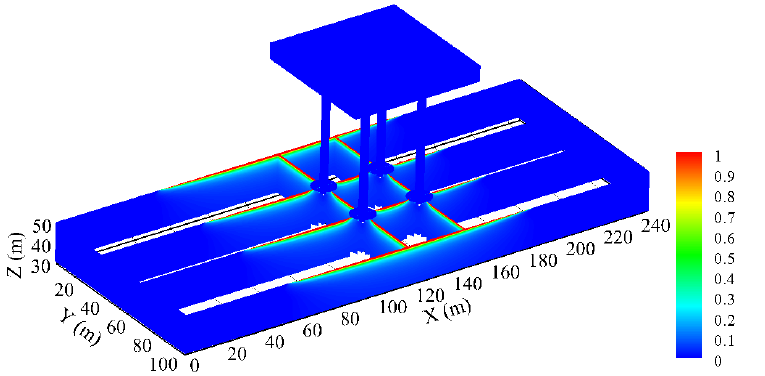
Figure 16. Predicted liquefaction zone in the seabed foundation when a wave trough reaches the jack-up offshore platform at t = 54.9 s in Case 2 ( H = 5 m, d = 50 m, T = 15 s) (note: the red zone is the liquefaction zone).